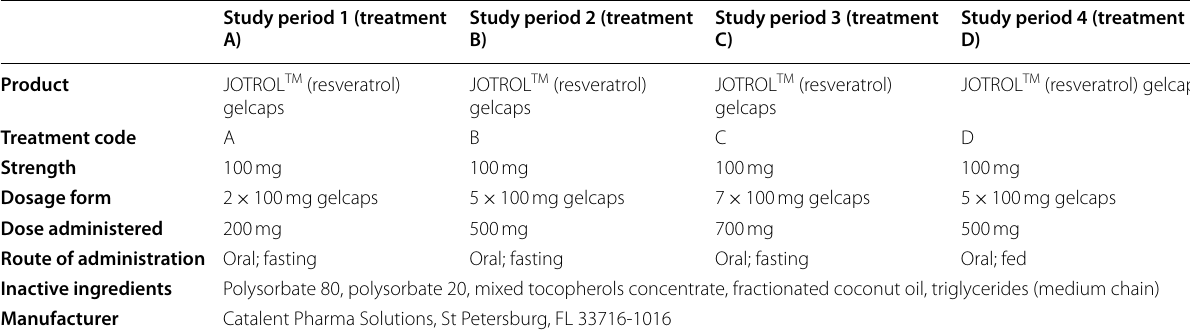
Table 1 Study drug formulation and test